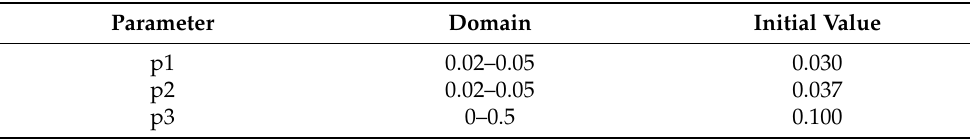
Table 2. The domains and initial values of the parameters of the developed decision model.